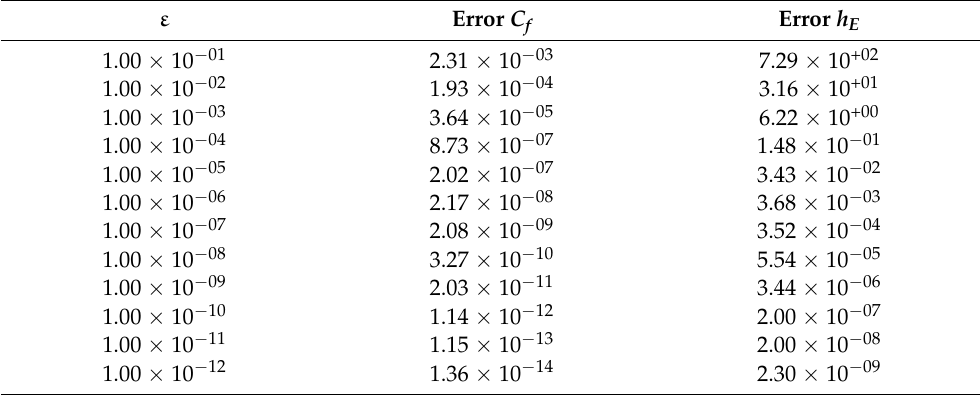
Table 2. Parameter error of solving equations.